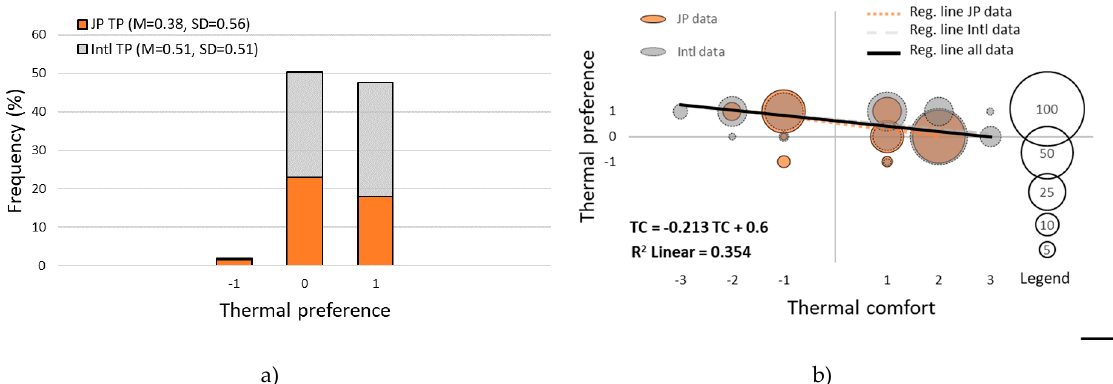
Figure 11. The frequency distributions and correlation between thermal responses; ( a ) Frequency distribution of TP; ( b ) correlation TP: TC.